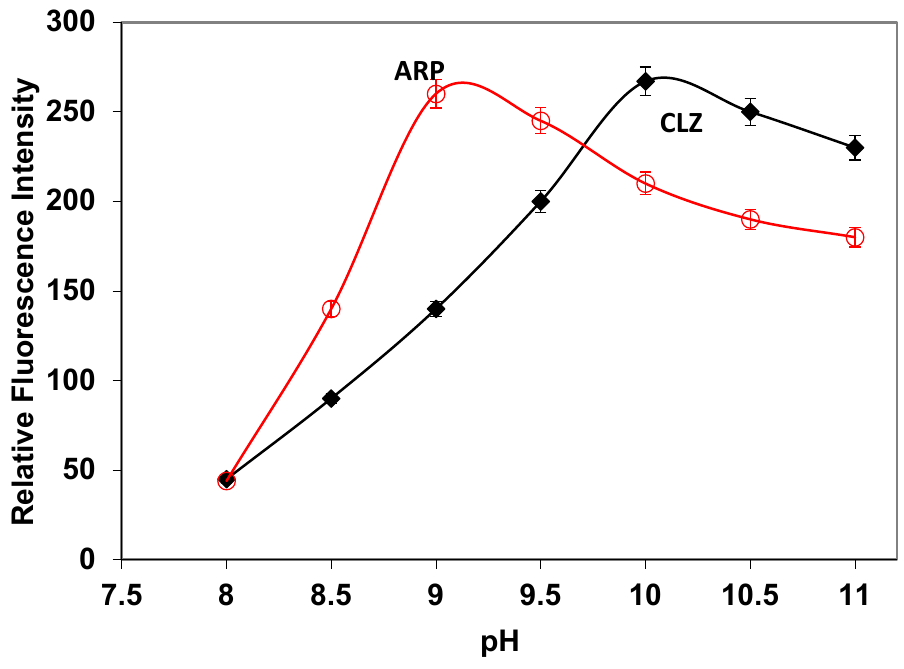
Figure 2. Effect of pH of borate buffer on the relative fluorescence intensity of the reaction product of ARP and CLZ with o -phthalaldehyde.